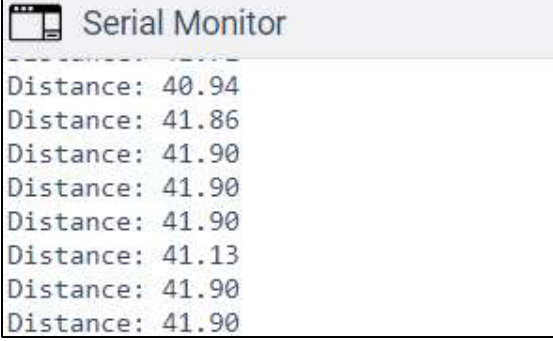
Fig. 9. Obstacle Avoidance System Reading 1